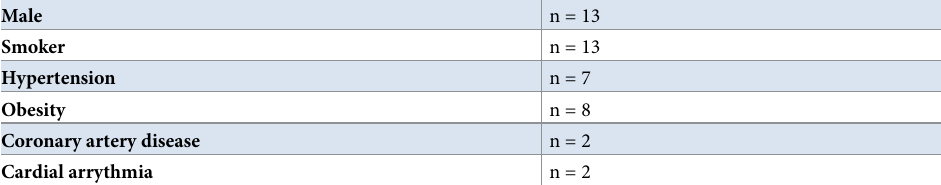
Table 5. Characteristics of the included subjects with cardiovascular risk factors.